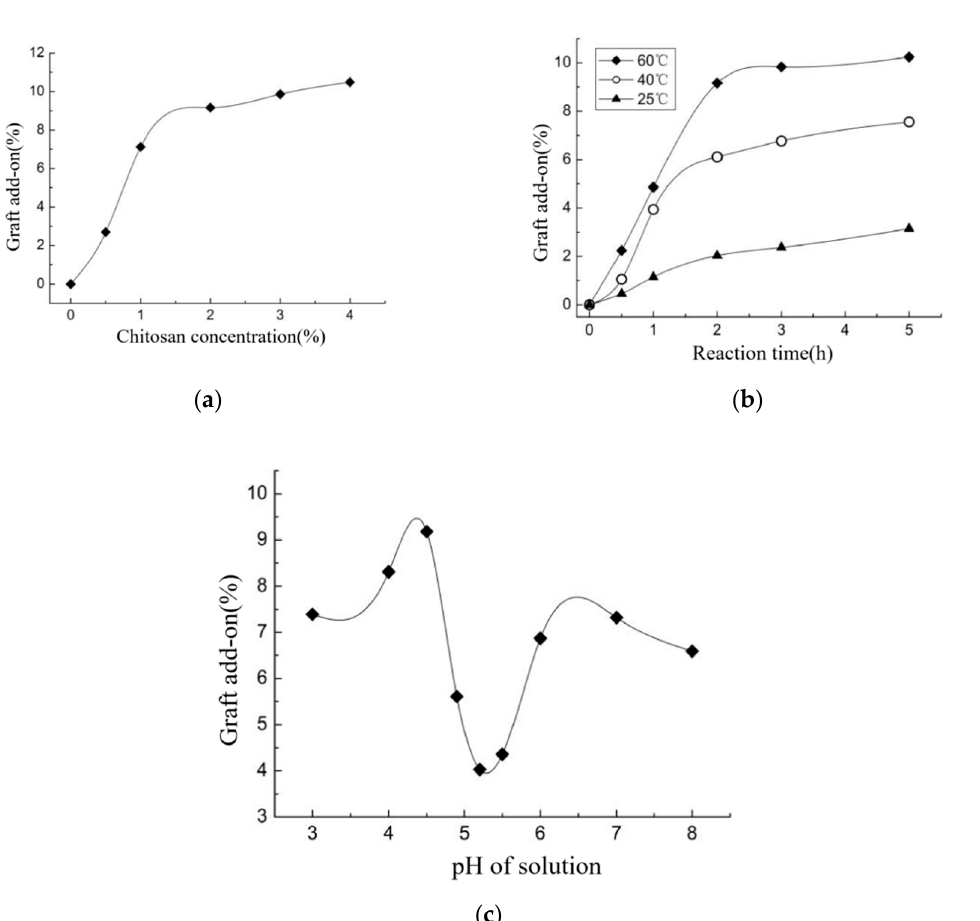
Figure 9. The effect of graft reaction parameters on graft add-on of chitosan on OCGCF. ( a ) The effect of chitosan concentration on graft add-on of chitosan on OCGCF, ( b ) the effect of reaction time and ( c ) the effect of pH of solution.